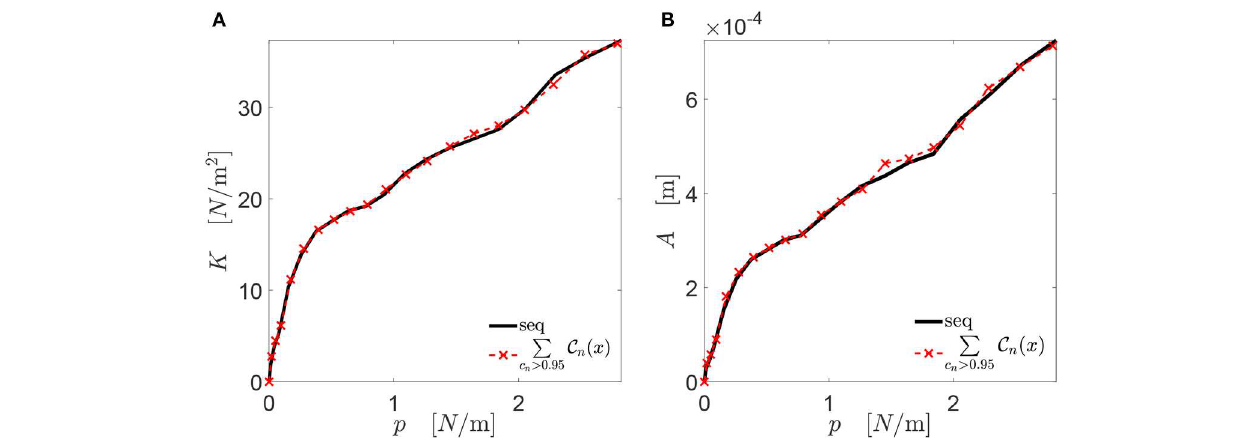
FIGURE 3 | Mechanical curve K ( p ) in (A) and A ( p ) in (B) for the alloy fractured profile in the one-dimensional case. The red line refers to the contact mechanics response of the profile obtained summing up all the chromosomes with a correlation coefficient c n larger than 0.95 with the complete K ( p ) curve. In the legend, “seq” stands for “sequenced,” and refers to the complete profile (the one identified from the whole set of